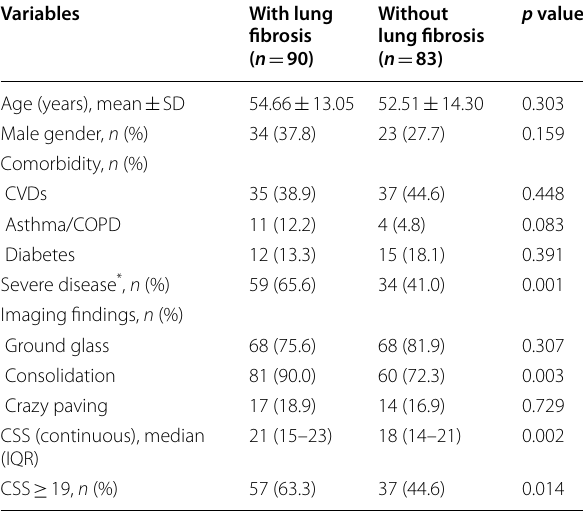
CVDs, cardiovascular diseases; COPD, chronic obstructive pulmonary disease; CSS, CT severity score; IQR, interquartile range